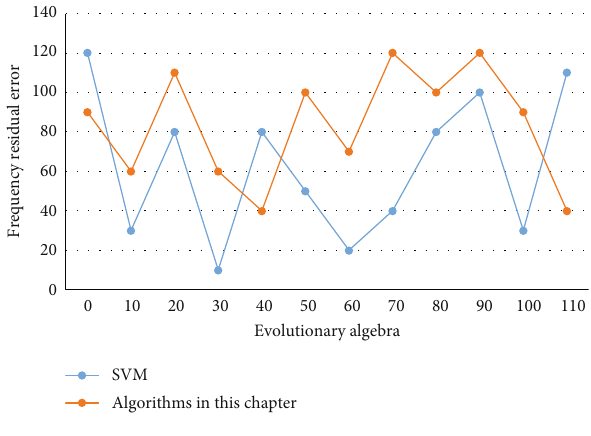
Figure 6: Deviation